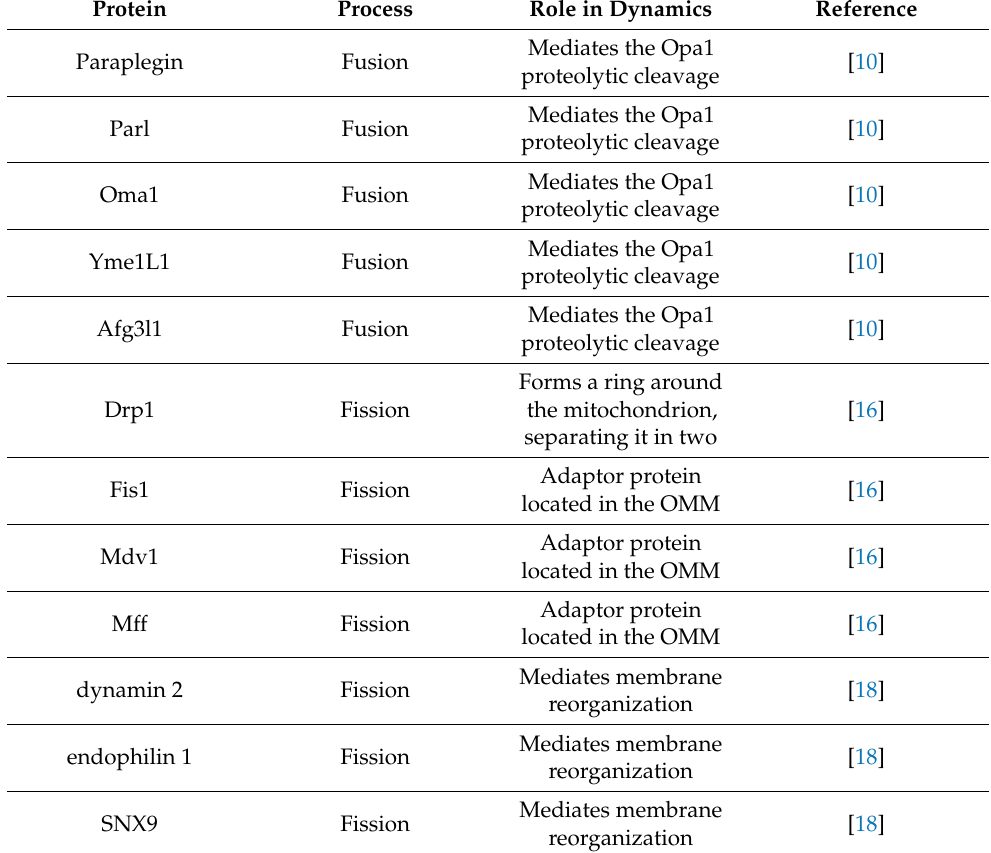
Table 1. Cont. Protein